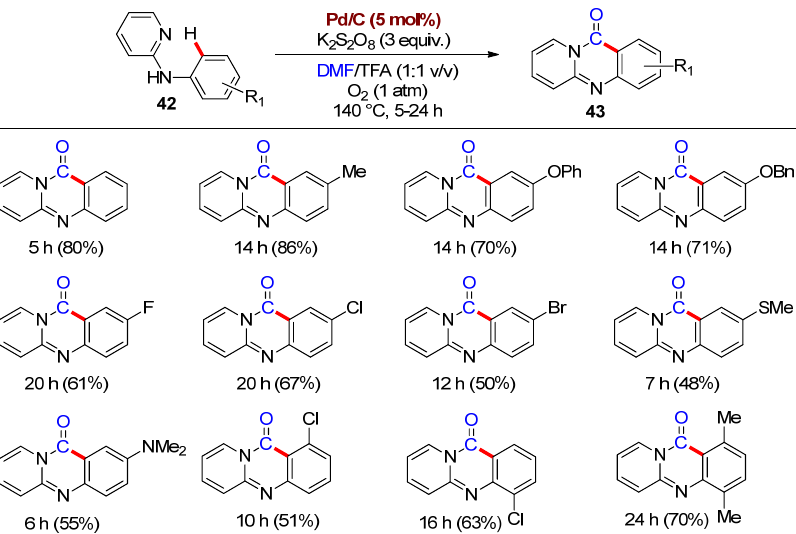
Scheme 16. Synthesis of quinazolinones 43 through carbonylative cyclization of N -arylpyridin-2-amines 42 with DMF as a CO surrogate catalyzed by Pd/C, developed in 2015 by Wu et al. [53]. For each heter-